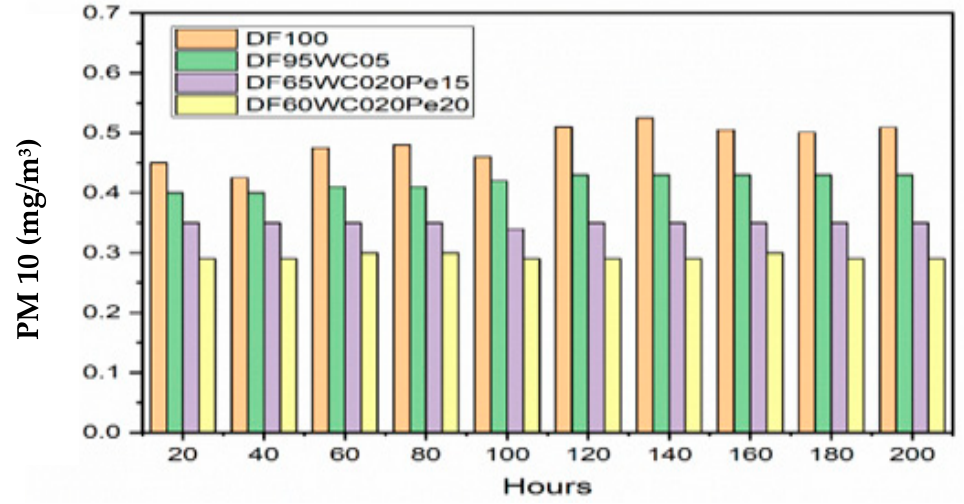
Figure 10. Particulate emission 10 (ppm) versus engine running hours.